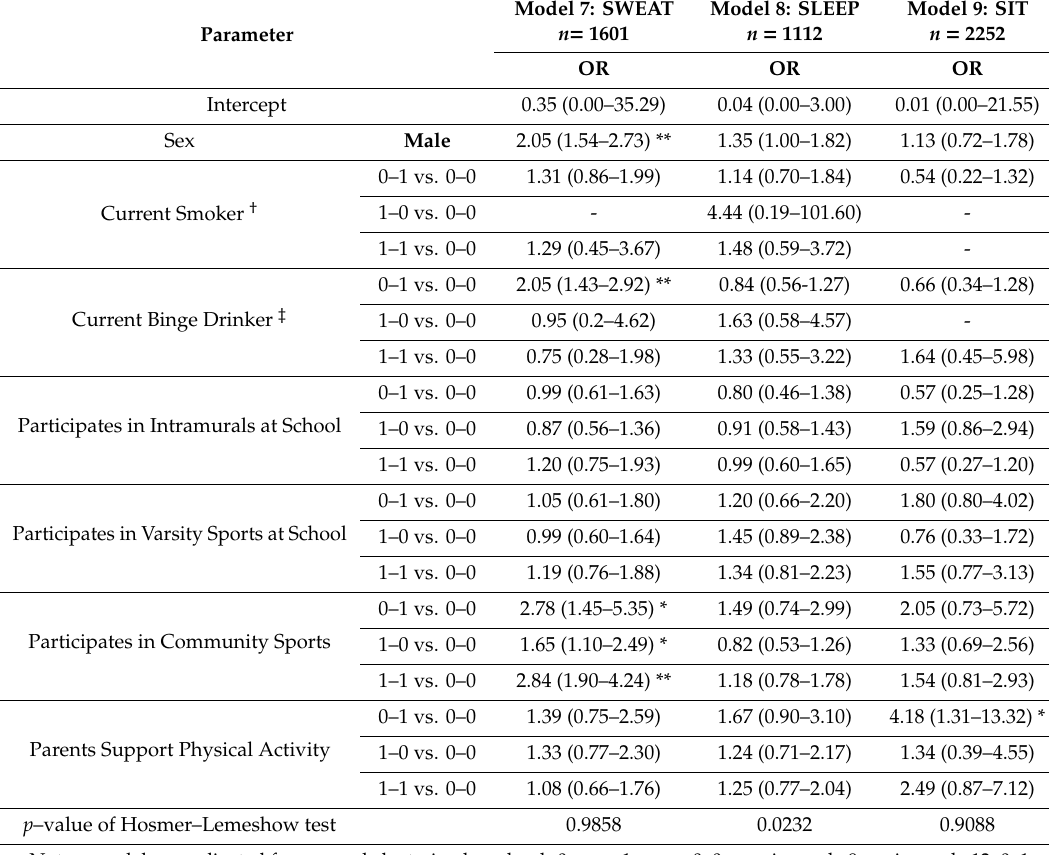
Table 6. Factors associated with meeting the 24-Hour Movement Guideline components in grade 12 among students who were not meeting the guideline in grade